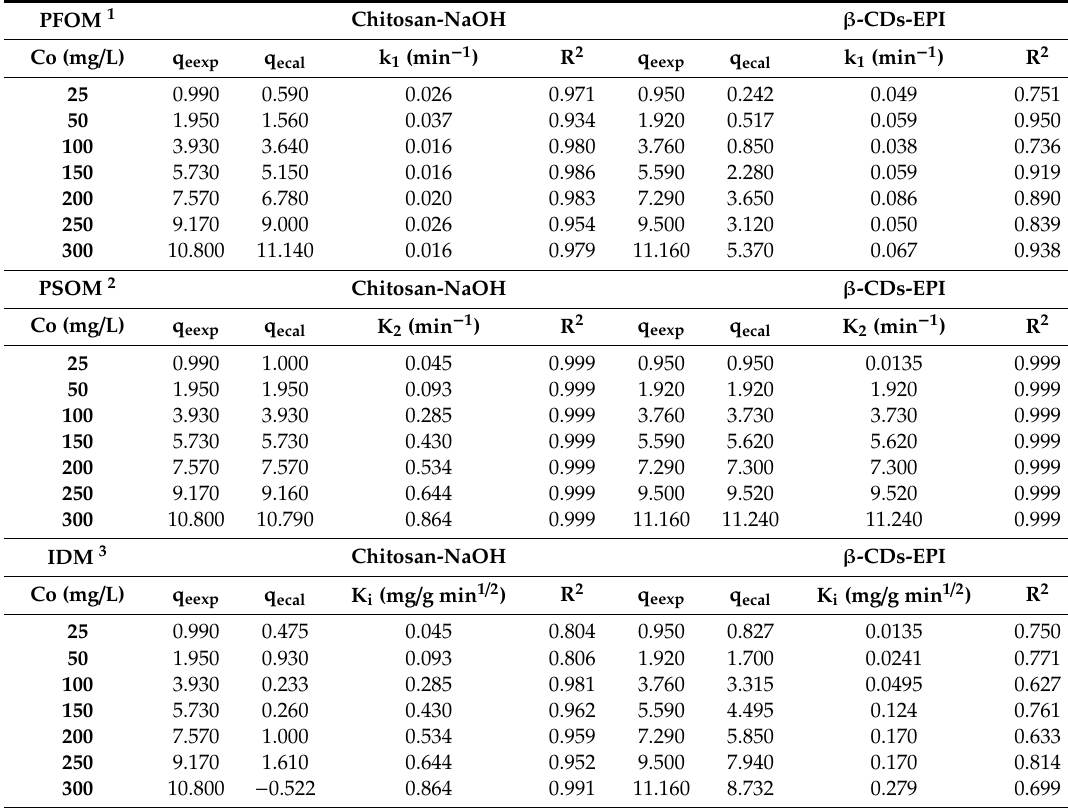
Table 2. The kinetics parameters of the Pseudo-First, Pseudo-Second-Order and Intraparticle Di ff usion Models for the adsorption of Direct Blue 78 onto chitosan-NaOH and β -CDs-EPI polymers.